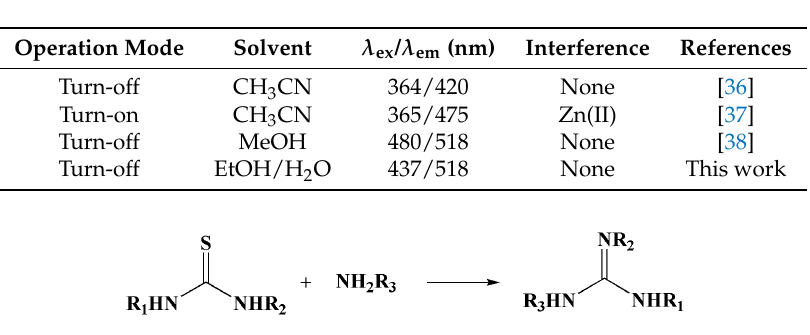
Table 1. Comparison of the recently reported sensors for the determination of Cu 2+